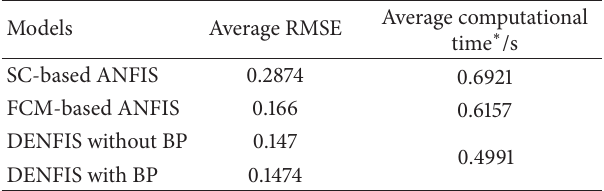
Table 2: Test performance of the NF models (simplicity).